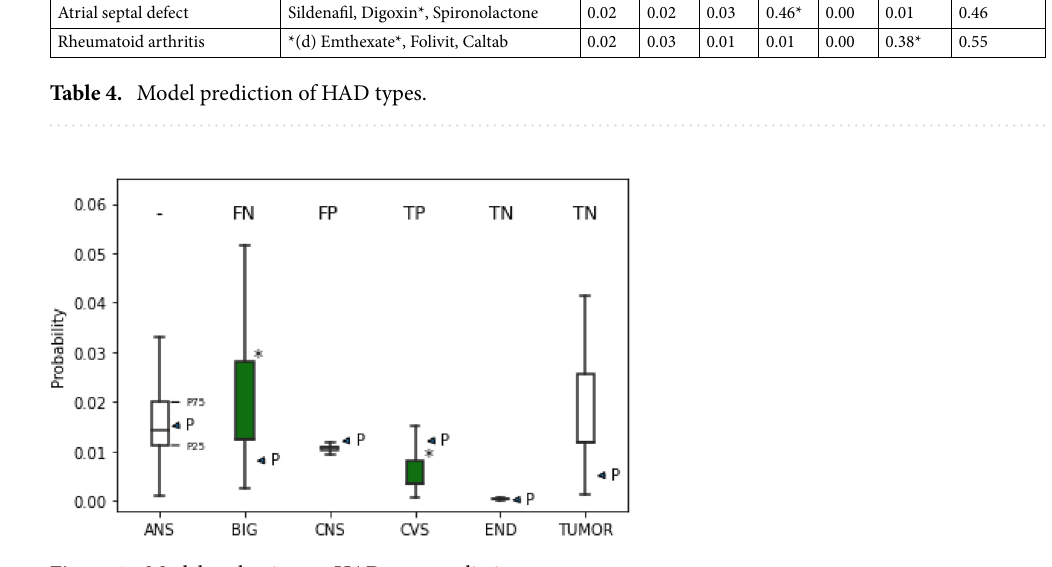
Figure 1. Model evaluation on HAD type